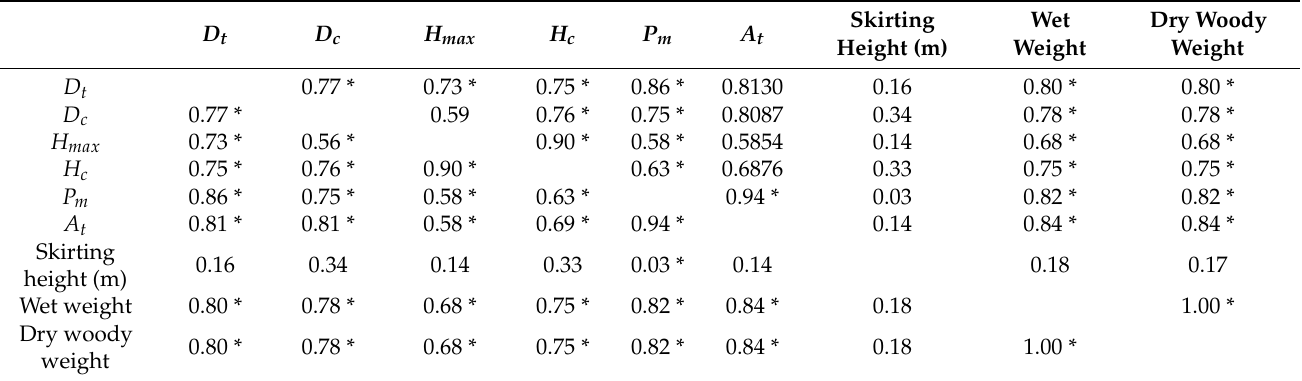
Table 5. Correlation matrix of the measured